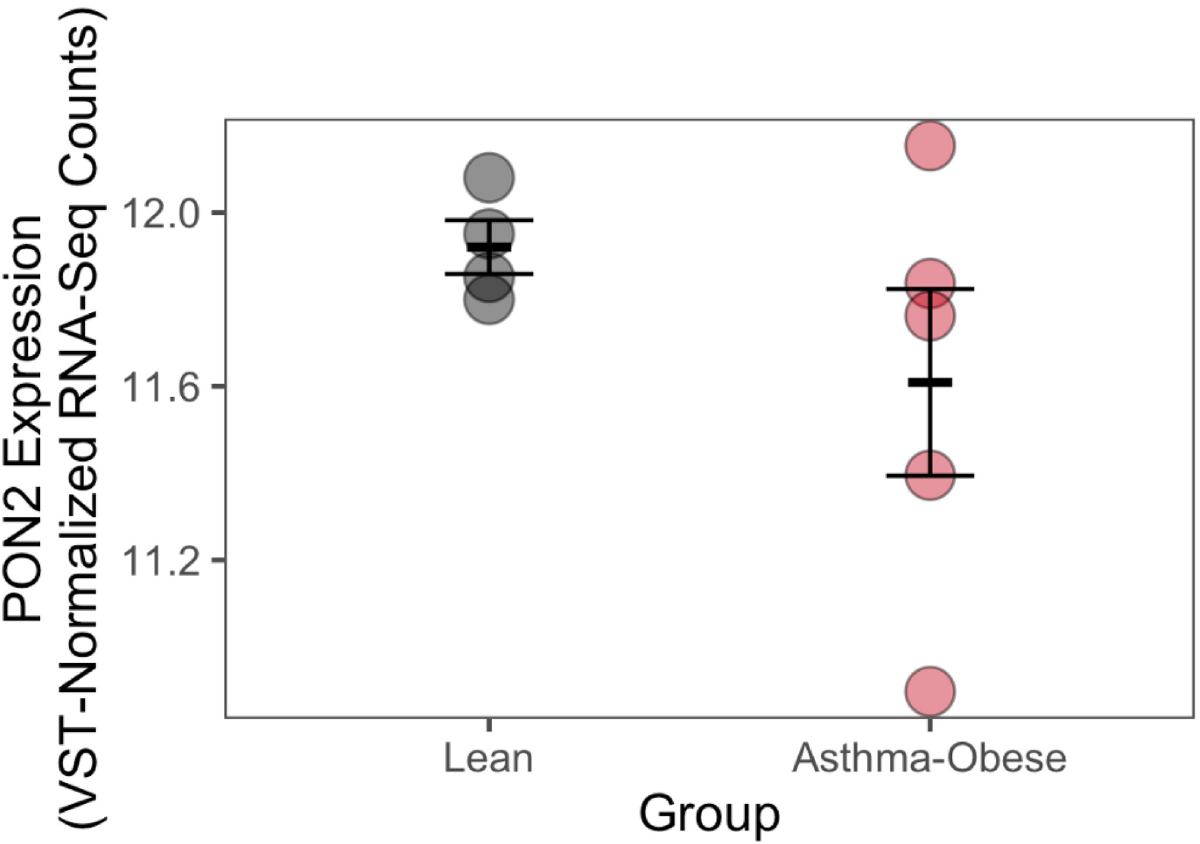
Fig 2. PON2 gene expression exhibits similar trends to the PON2 protein concentration levels measured using Western blot, with a trend towards decreased PON expression in asthma-obese (n = 5, 11.6 ± 0.22; mean ± standard error in VST-normalized messenger RNA levels) compared to lean participants (n = 4, 11.9 ± 0.062). The error bars depicit mean ± standard error.